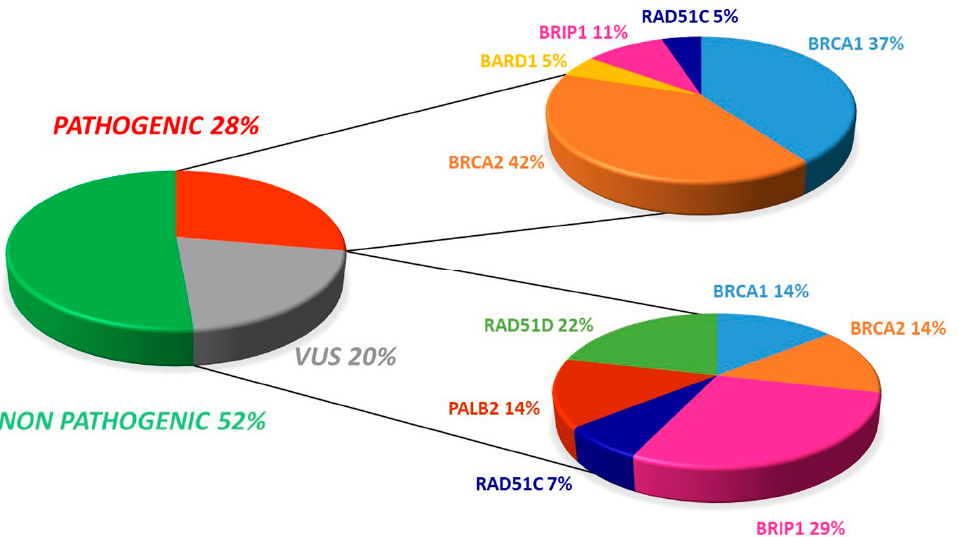
Figure 1. Overall distribution of deleterious and uncertain significance variants in our cohort. The spectrum of identified mutations includes 19 single-nucleotide variants (6 nonsense, 12 missense, and 1 splice variant) and 14 indels (8 deletions, 5 duplications, and 1 indel) (Figures 2–4).